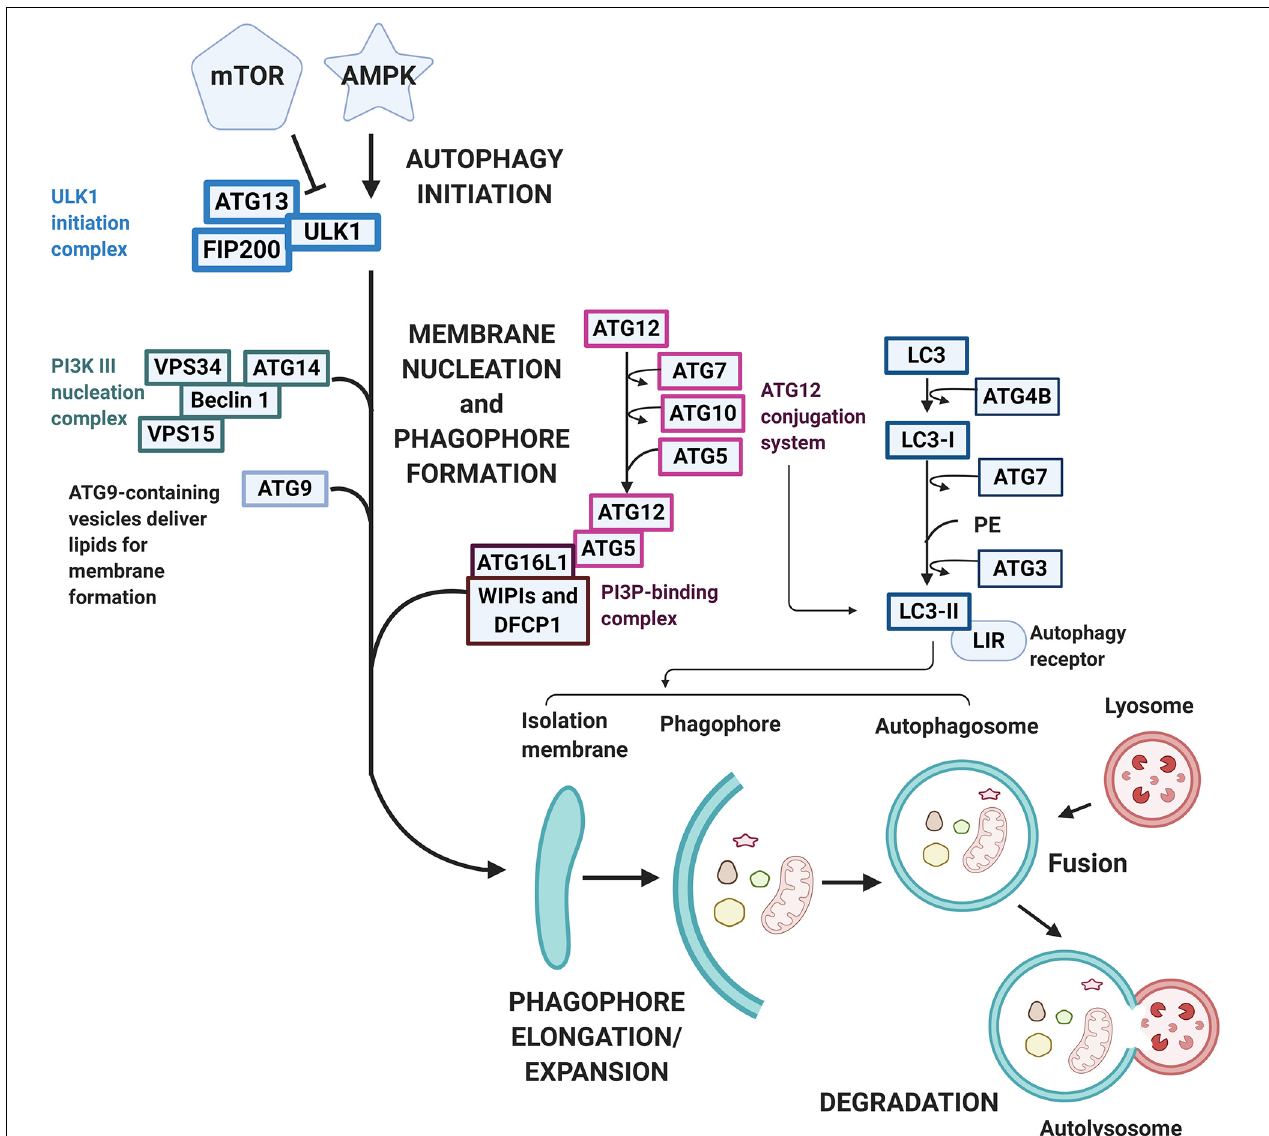
FIGURE 3 | Macroautophagy pathway and signaling. Macroautophagy is activated following various stimulation under cellular stress conditions. The autophagic pathway typically includes several steps including (1) initiation, (2) phagophore formation, (3) elongation/expansion, (4) autophagosome-lysosome fusion, and (5) degradation. mTOR and AMPK regulates the initiation process with AMPK acting as an activator while mTOR acts as an inhibitor. Under cellular stress, mTOR reduces its inhibition on the ULK1-FIP200-ATG13 complex, whereas AMPK reduces mTORC activity and directs ULK-1 to the site of autophagy. The ULK-1 complex regulates the nucleation and phagophore formation process through the recruitment of VPS34 and the formation of PI3P. PI3P then contributes to the phagophore formation through the signaling of WIPI2B and DFCP to drive the phagophore formation. A double-membrane vesicle (phagophore) begins to form and elongate into an autophagosome through two ubiquitin-like conjugation cascades, the ATG5-ATG12 and the LC3 systems. The LC3 is first processed to LC3-I by ATG4B and then activated by ATG7. LC3-I is later transformed into LC3-II via ATG3 and incorporated into the limiting membrane which harbors the LIRs. The sealed degradation components are then further degraded in an acidic environment containing hydrolytic enzymes through the fusion of the matured autophagosome with lysosome to form an